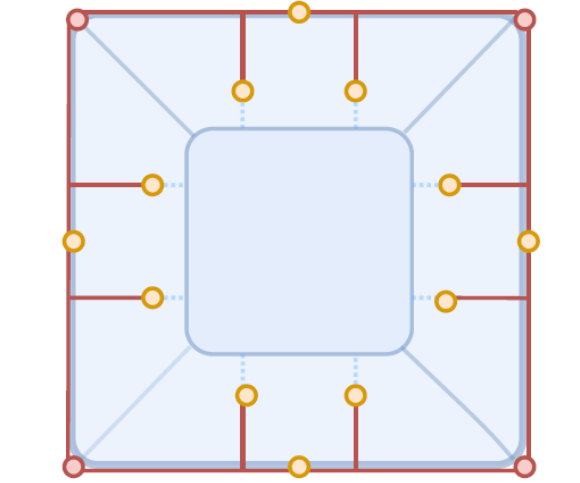
Figure 11: Proposed flappable mobile control point frame for waste bins with coded